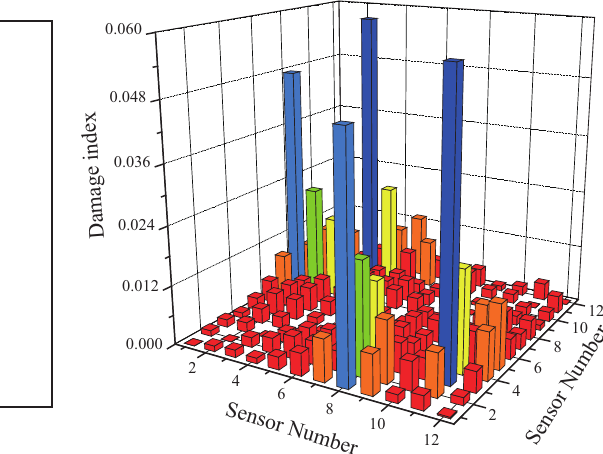
Fig. 8. Damage indices of all